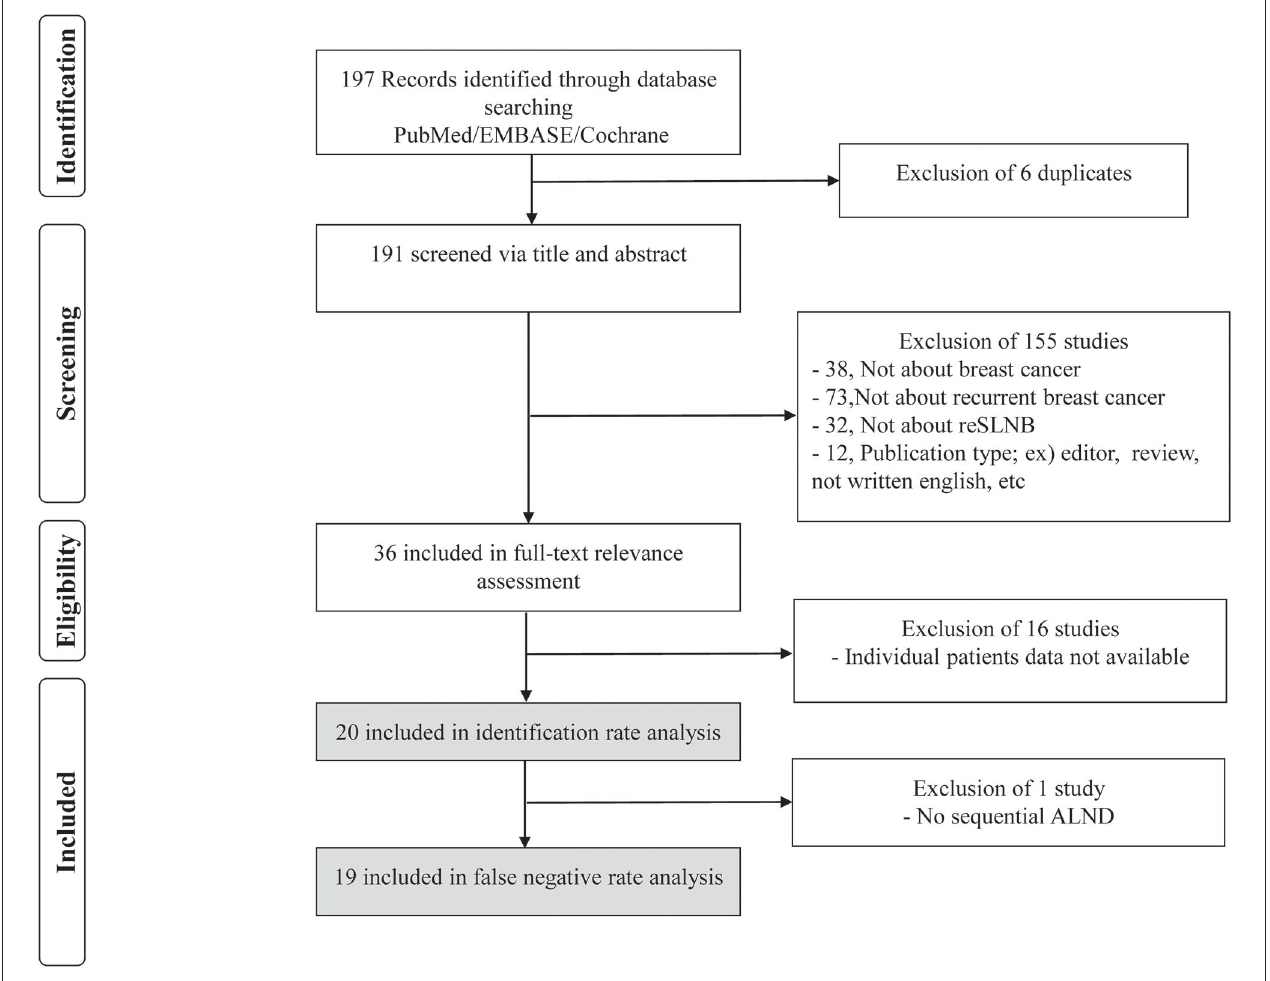
FIGURE 1 | Flowchart for the search strategy on repeat sentinel lymph node biopsy in patients with local recurrence. Our search strategy found 197 abstracts. Of these 197 abstracts, 6 were excluded due to duplication, and 155 were excluded based on predefined exclusion criteria. The remaining 36 articles were fully reviewed, of which 16 were excluded because they failed to meeting inclusion